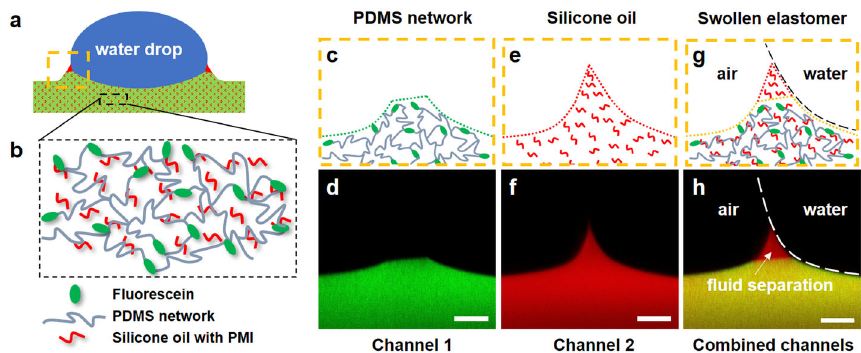
Fig. 2 Visualizing the network and fl uid parts separately at the contact line. Schematics of ( a ) a water drop on a swollen surface, and ( b ) the PDMS elastomer, where the network is dyed with fl uorescein and the silicone oil is dyed with PMI. c – h Schematics and corresponding confocal images of a wetting ridge for a swollen network with a water drop deposited on the surface. c , d Channel 1 shows the PDMS network (green), ( e , f ) channel 2 shows the silicone oil (red), and ( g , h ) the combination of channels 1 and 2 show both parts (yellow). Scale bars: 20 µ